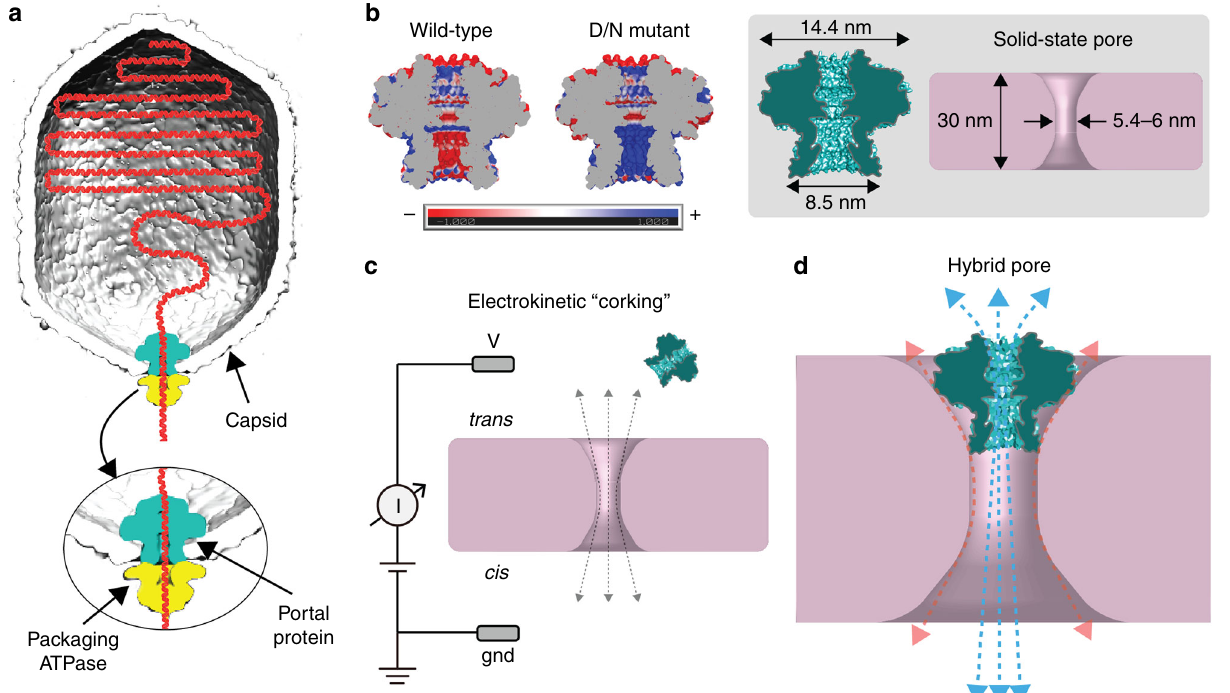
Fig. 1 Design of a bio-inspired lipid-free hybrid nanopore. a Cartoon of the DNA packaging machine of a dsDNA virus. Viral genomic DNA (red) is translocated into the preformed virus capsid by the packaging ATPase (yellow) through the portal protein (aqua) embedded in viral capsid (gray). b Left, electrostatic properties of the tunnel in wild-type and mutant portal proteins. Slice through the middle of molecular surface colored according to charge from red ( − 1 kT e − 1 ) to blue ( + 1 kT e − 1 ). b Right (gray box), dimensions of the portal protein (teal, L) and the SS nanopore (pink, R). c Insertion of the puri fi ed portal protein into a nanopore fabricated in a thin solid-state (SS) membrane. Portal protein is applied to the trans chamber of a SS nanopore device containing an electrolyte solution of 20 mM Tris pH 7.5, 0.5 M NaCl. The protein electrokinetically inserts into the SS pore during application of a positive voltage. d Cartoon image of the hybrid pore, in which application of voltage results in ion current through the pore (blue arrows), as well as leakage current that is peripheral to the pore (red